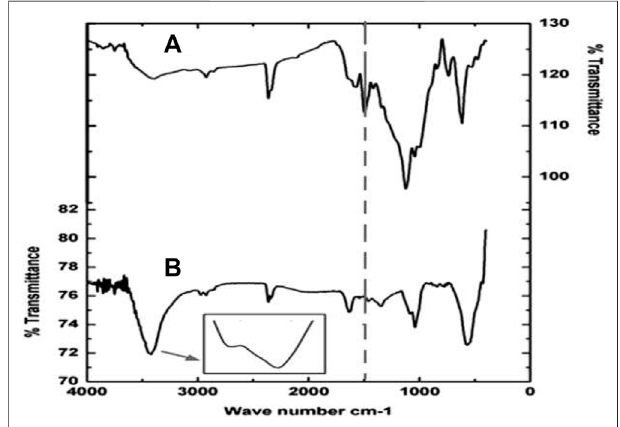
FIGURE4|(A) FTIRAnalysisofControl(Ef fl uent containingthedye)and (B) FTIR Analysis of Bacterial treated ef fl uent (23